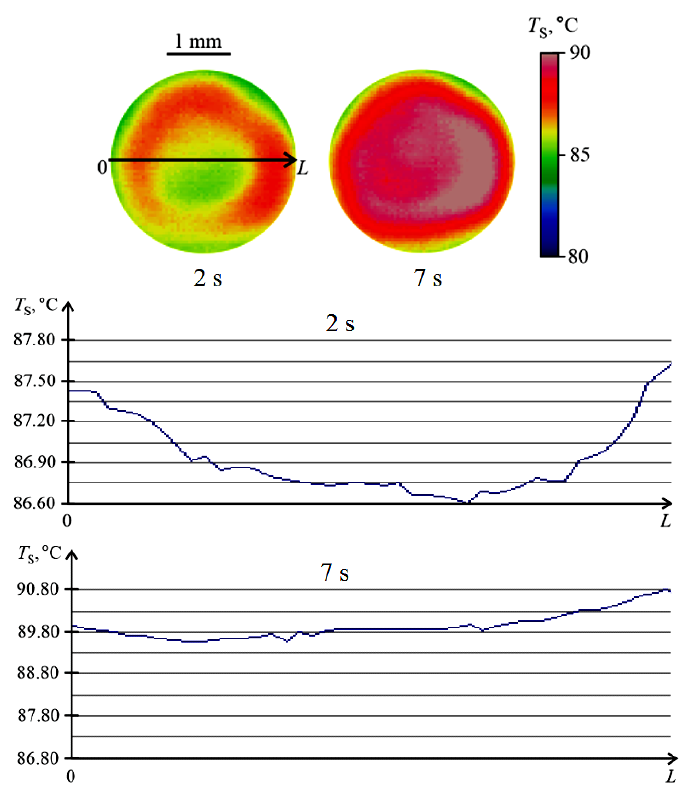
Figure 12. Thermal images of the droplet interface and temperature profiles at the cross section of 0 L ( T w = 91 °C, water with surfactant at 10,000 ppm concentration). The temperature profile of the droplet surface at a high wall temperature ( T w = 90 °C) is qualitatively similar to that at an unheated wall. (Figure 10b). The minimum tem-